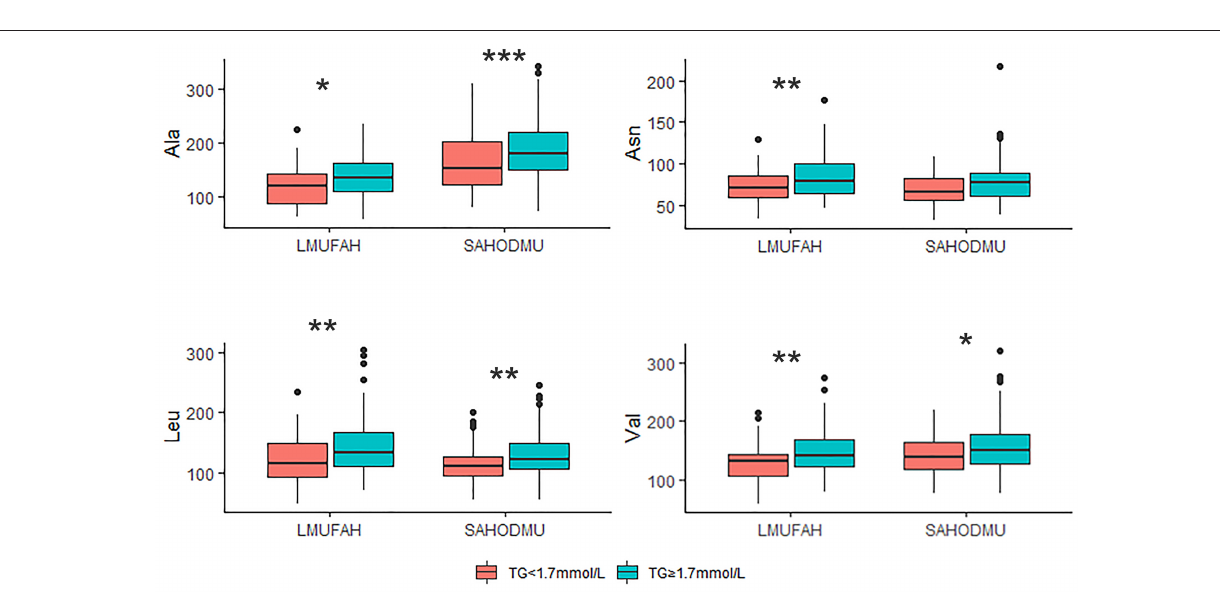
FIGURE 3 | Plasma amino acids levels in patients with LDL-C ≥ 2.6 mmol/L according to TG levels. LDL-C, low-density lipoprotein cholesterol; TG, triglyceride; LMUFAH, Liaoning Medical University First Affiliated Hospital; SAHODMU, the Second affiliated hospital of Dalian Medical University; Ala, Alanine; Asn, Asparagine; Leu, Leucine; Val, Valine. * P < 0.05; ** P < 0.01; *** P <